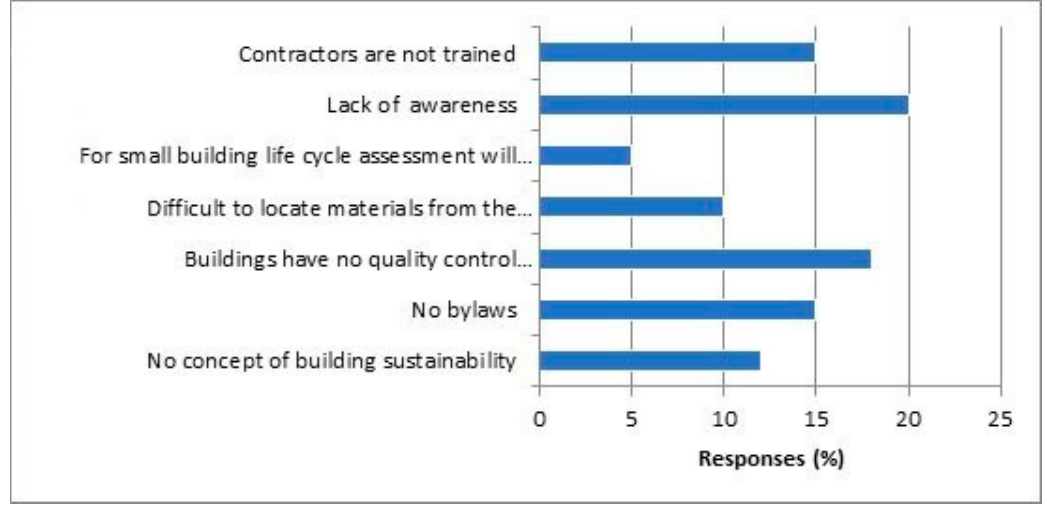
Figure 7. Barriers in life cycle adoption.